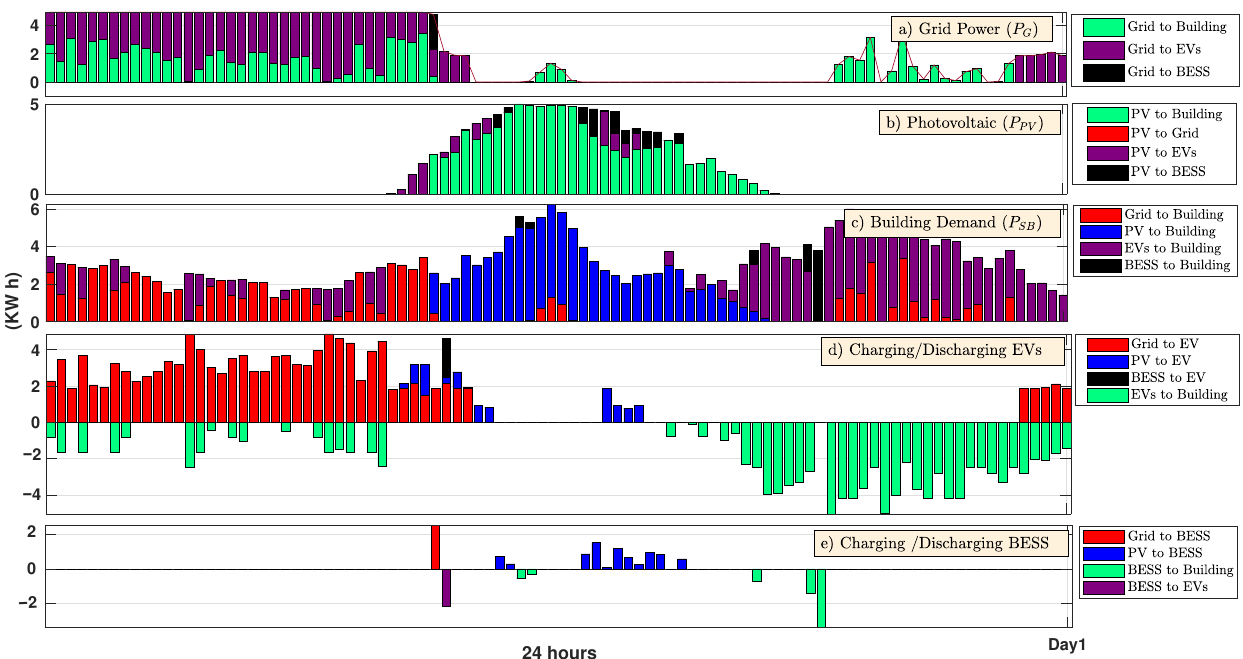
Figure 3. Trace of power among Grid, Building’s apartments, Photo Voltaics (PVs), Electric Vehicles (EVs) and Battery Energy Storage System (BESS) corresponding to (cid:101) =